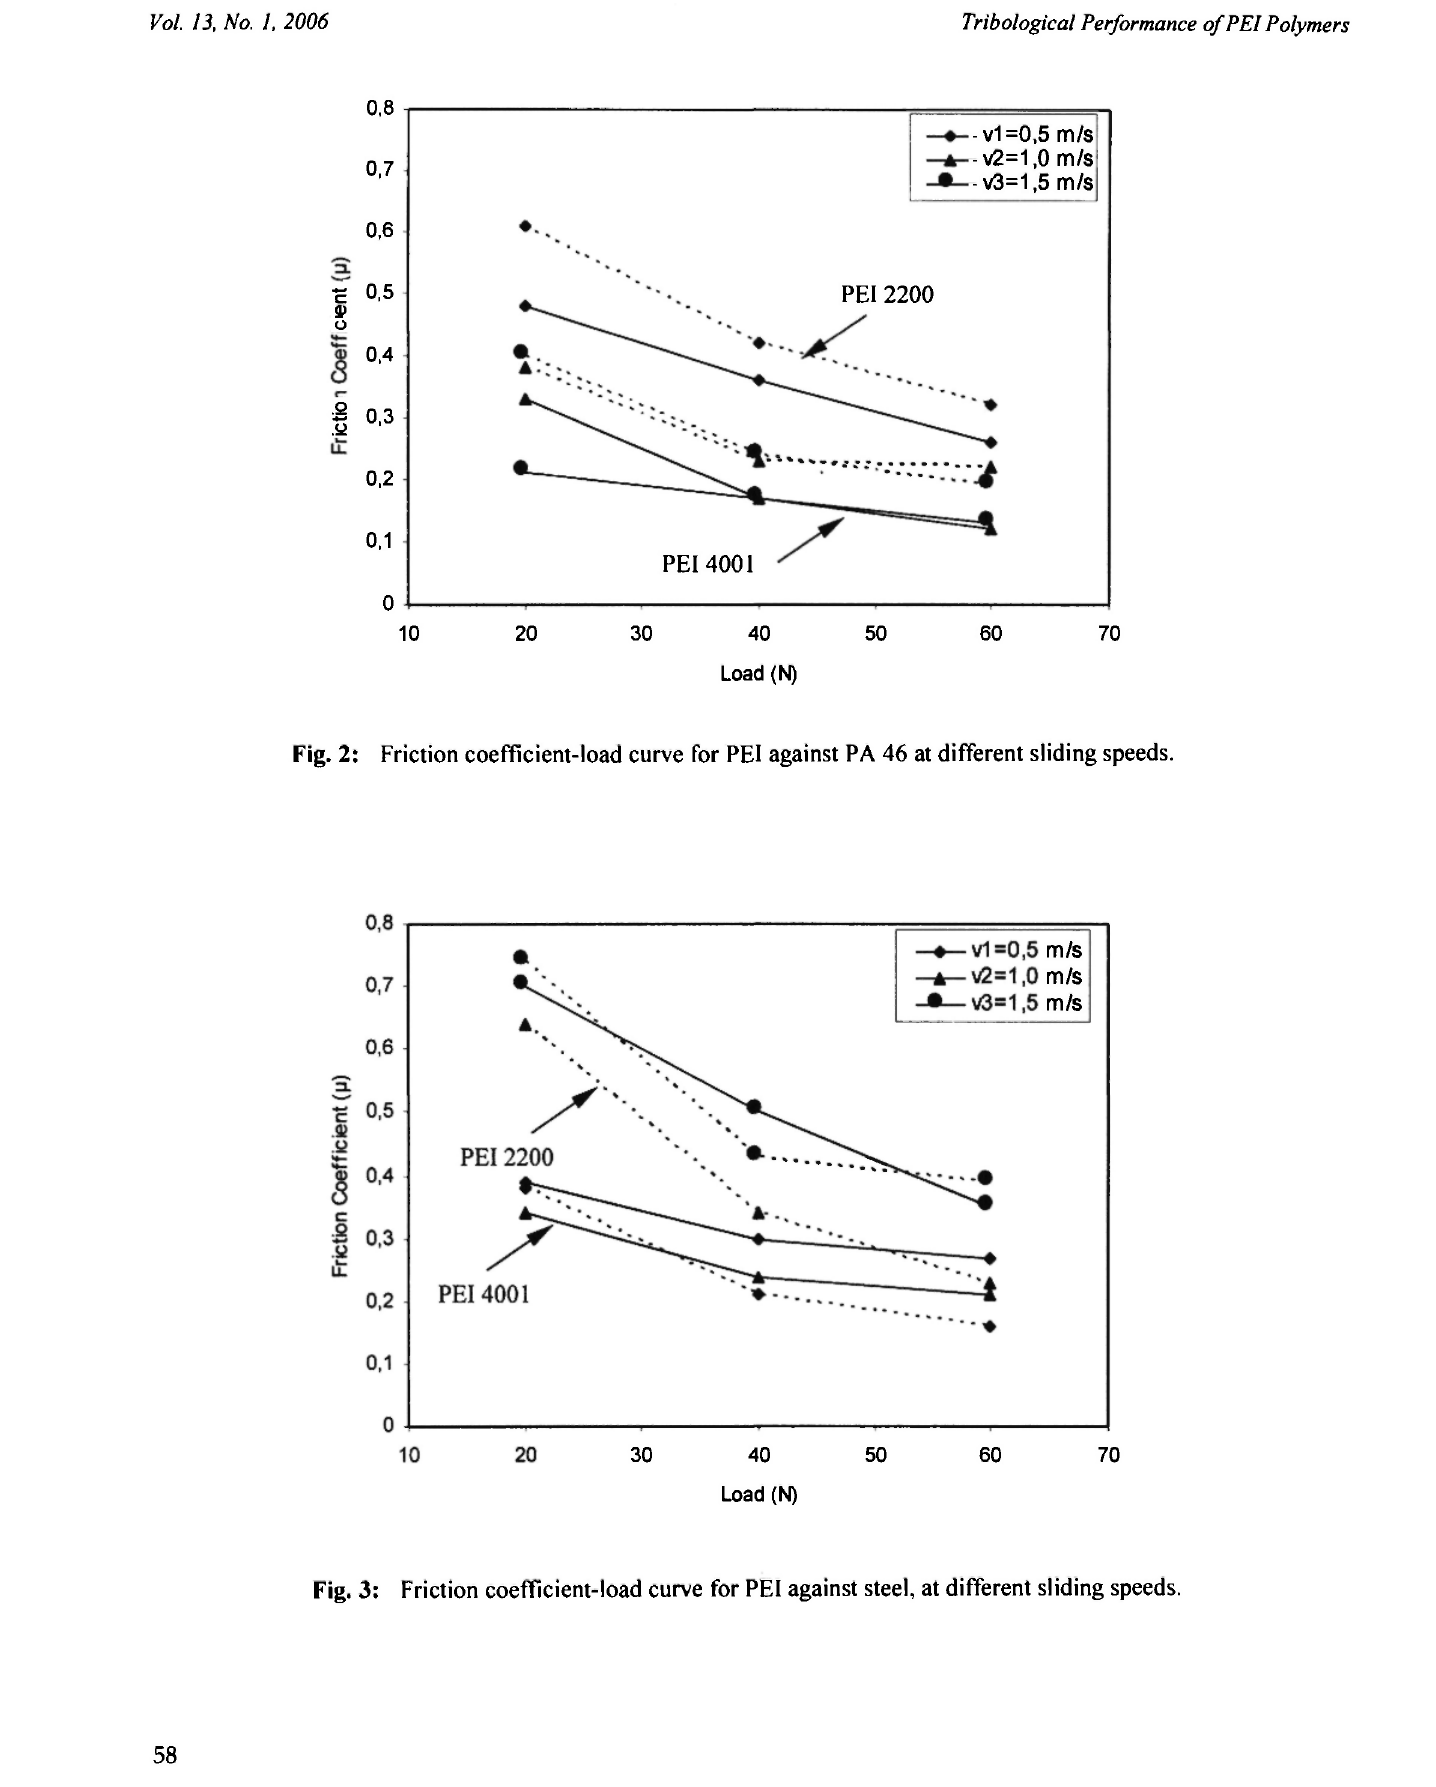
Fig. load curve for PEI against steel, at different sliding speeds. 3: Friction